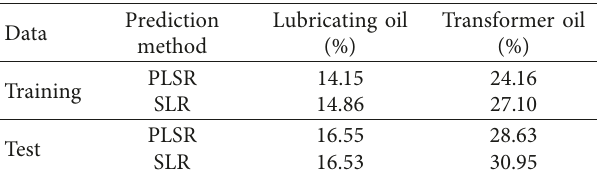
Table 8: The average % RMSE of prediction using partial least squares regression (PLSR) and simple linear regression (SLR) based on 100 training/test sets (concentration ranges